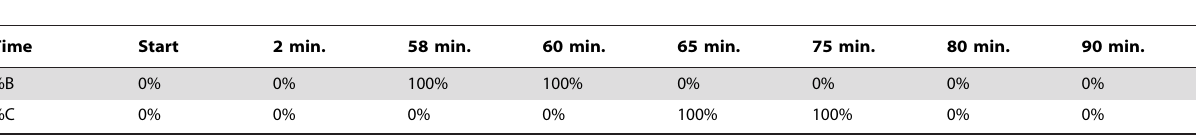
Table 4. LC gradient for strong cation exchange